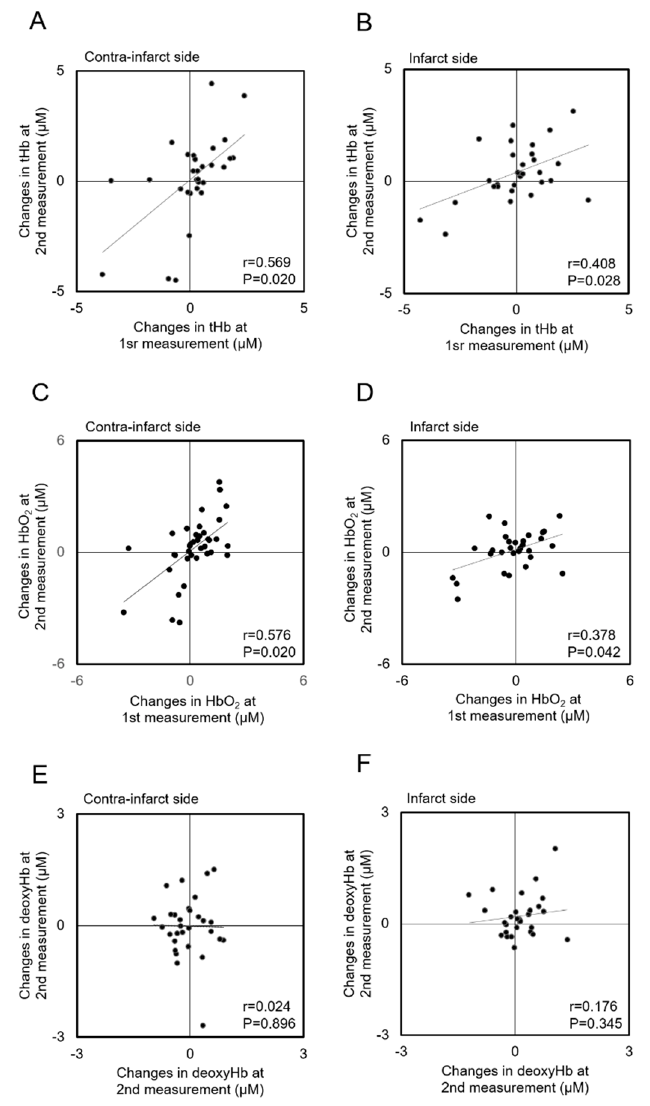
Figure 4. Scatterplots of the changes in total-hemoglobin (tHb) ( A and B ), oxygenated-hemoglobin (HbO 2 ) ( C and D ), and deoxygenated-hemoglobin (deoxyHb) ( E and F ) concentrations in response to head-of-bed elevation (from 0° to 30°) between the first and second measurements for each hemisphere.